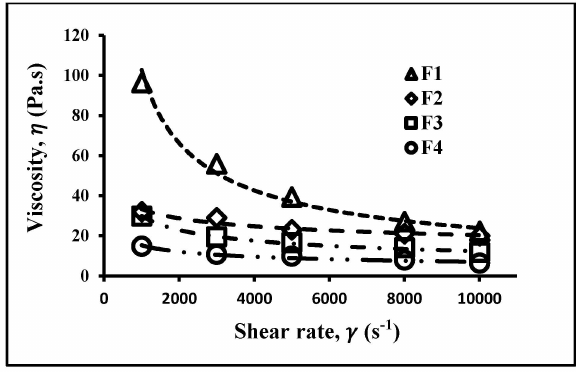
Figure 6. Effect of shear rate on viscosity changes at 170 ˝ C for different binder